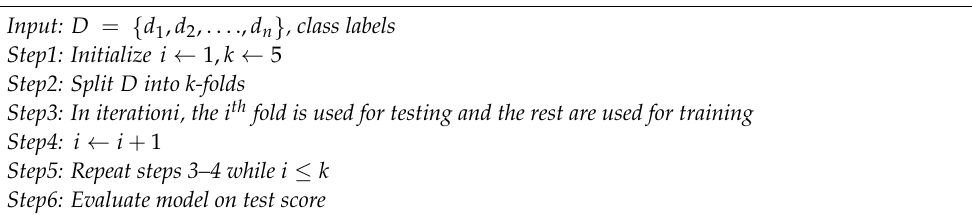
Algorithm 5: Algorithm for the k-fold cross